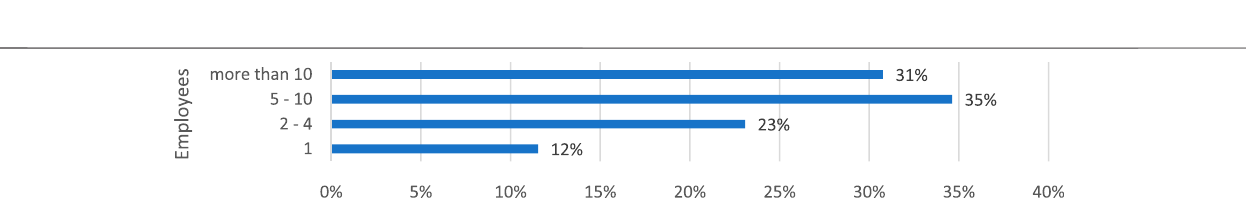
FIGURE 3 | Answers regarding the number of employees that have data-entry tasks in the organization.